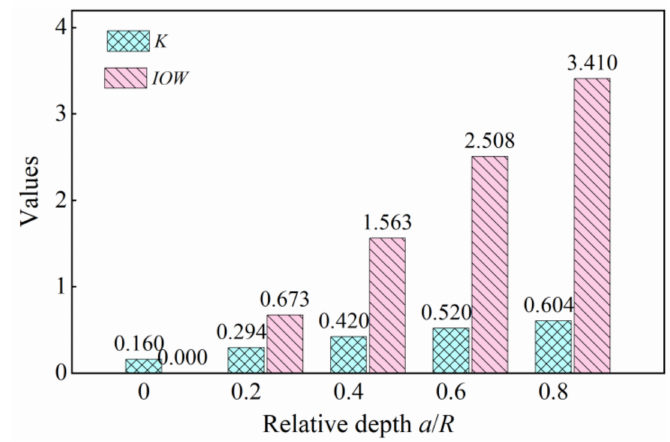
Figure 7. The values of IOW and K